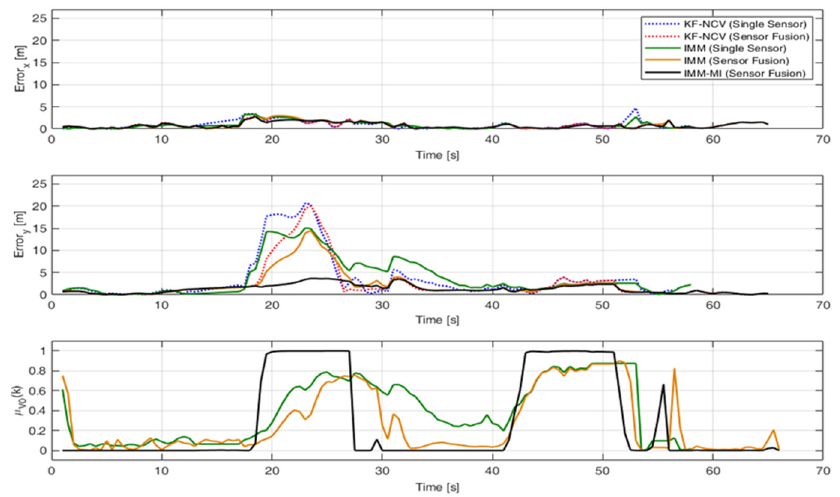
Figure 13. Positioning errors and V0 model probabilities in the experimental data for human target localization and tracking.